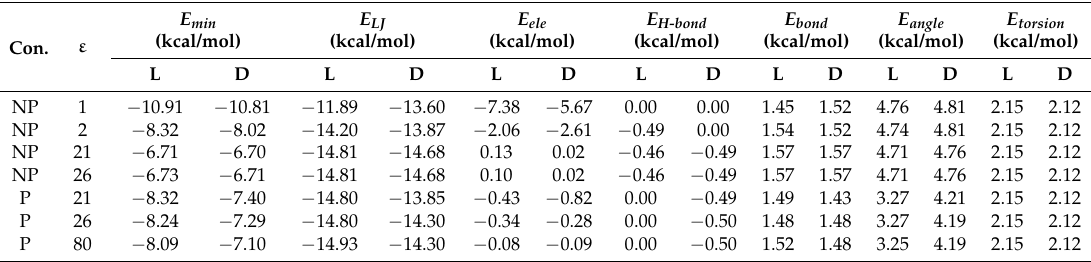
Table 1. The minimum interaction energy E min obtained with the AMBER force field for each enantiomer and the different contributions: Lennard-Jones E LJ , electrostatic E ele , hydrogen bonding E H-bond , bond stretching E bond , angle bending E angle and torsional energy E torsion . E min E LJ (kcal/mol) Con.